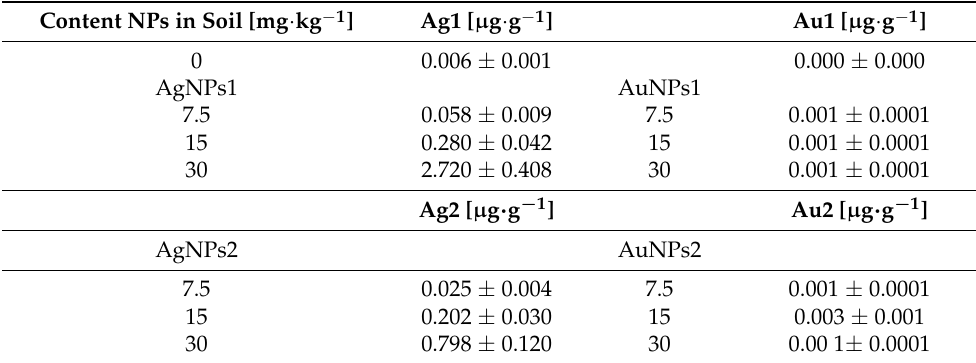
Table 1. Content of Au and Ag ions ( ± SD) in leaves after 8 weeks